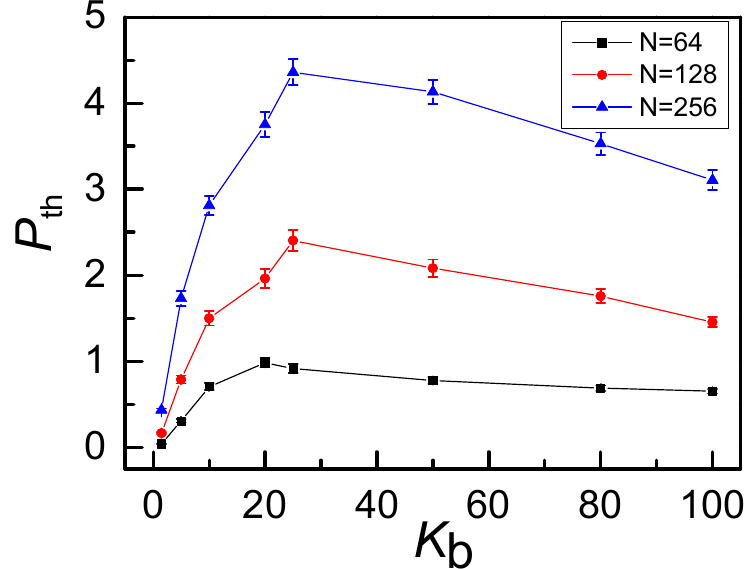
Figure 11. Average threading number P th increases with the chain length ( N ) and has a peak at K b = 20~25 for 0 1 -knot ring polymers at ρ = 0.1.